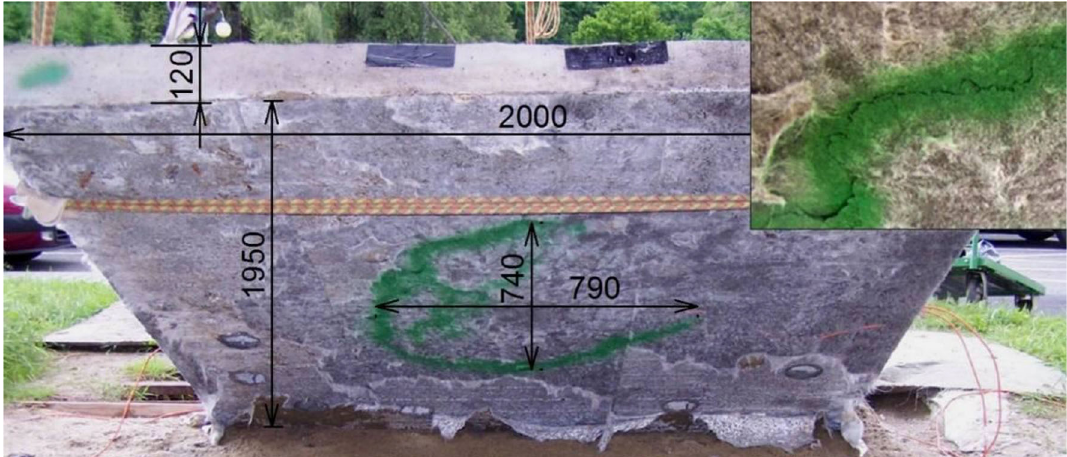
Fig. 4 Cracks on the bottom surface of the slab